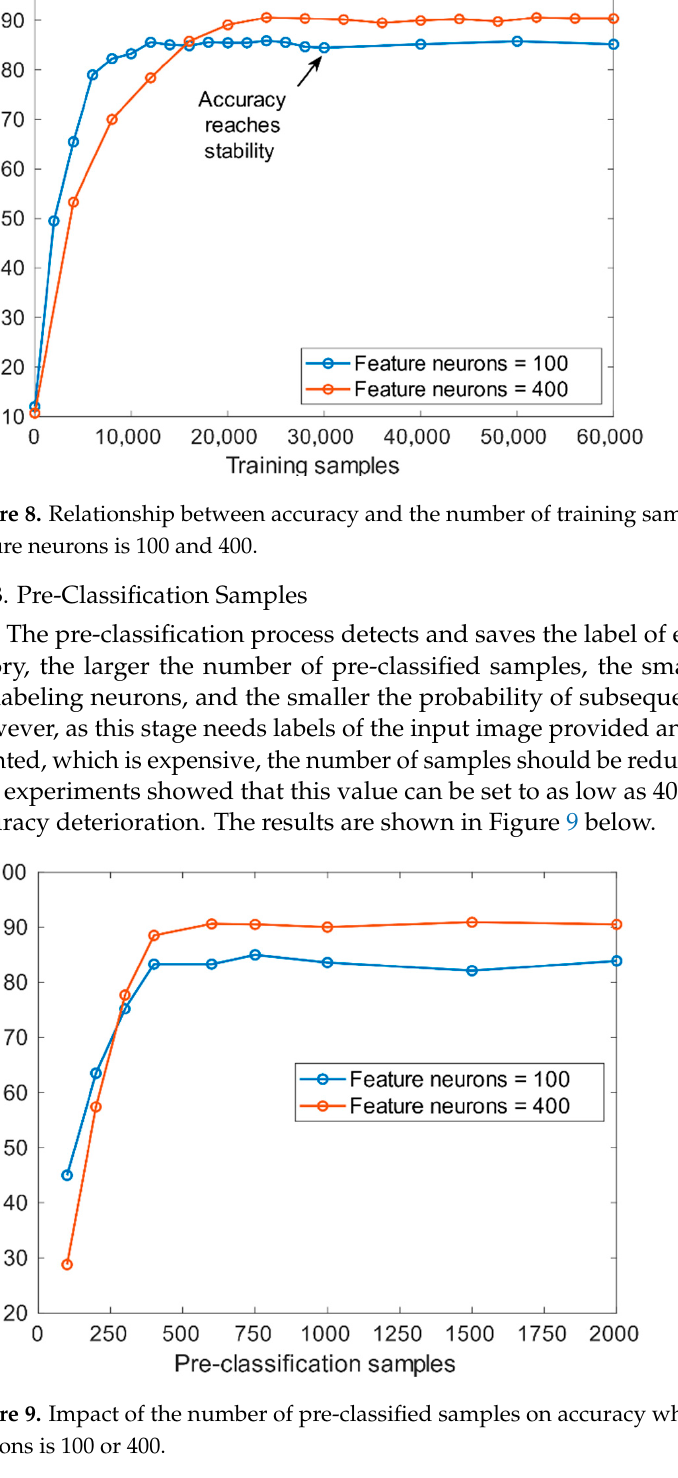
11 of 16 Figure 7. Changes in weight image of a single feature layer during training (samples = 0, 1000, 2000, 3000, 4000, 5000, 6000). Training sample size affects the similarity between the synaptic weight of the feature neuron and its label features. After the training, the weight value is fixed. As our classification algorithm uses winner-take-all, the higher the similarity, the clearer the features (which indicates the more complete the training), the more specific the features recognized by the neuron, and, finally, the higher the recognizing accuracy. We tested the impact of training sample size on accuracy when the input image is 28 × 28 and the number of feature layer neurons is 100 or 400, and the results are as follows.